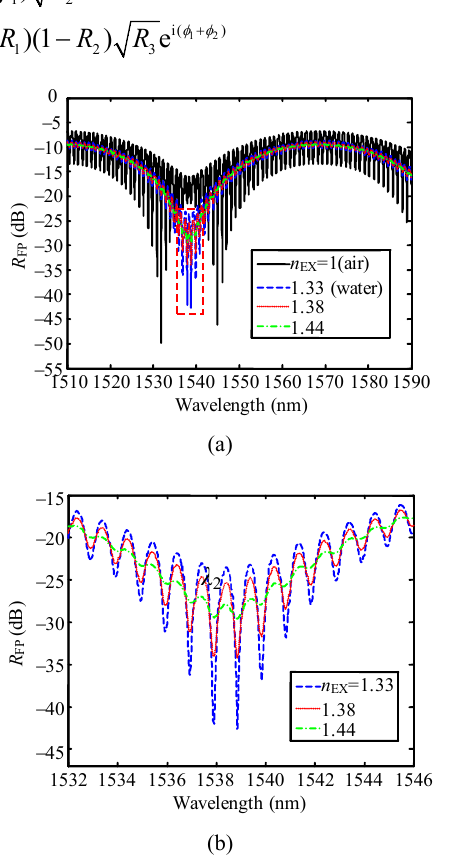
Fig. 2 Simulated interference spectra: (a) n EX = 1, 1.33, 1.38, and 1.44, respectively (other simulated parameters are: n SMF = 1.457, n HCPCF = 1, L 1 = 20 µ m, L 2 = 775 µm, α 1 = α 2 = 0.15, γ 1 = 0.02, γ 2 = 0.01, and λ is from 1 510 nm to 1 590 nm) and (b) close-up of the spectra in liquids of different